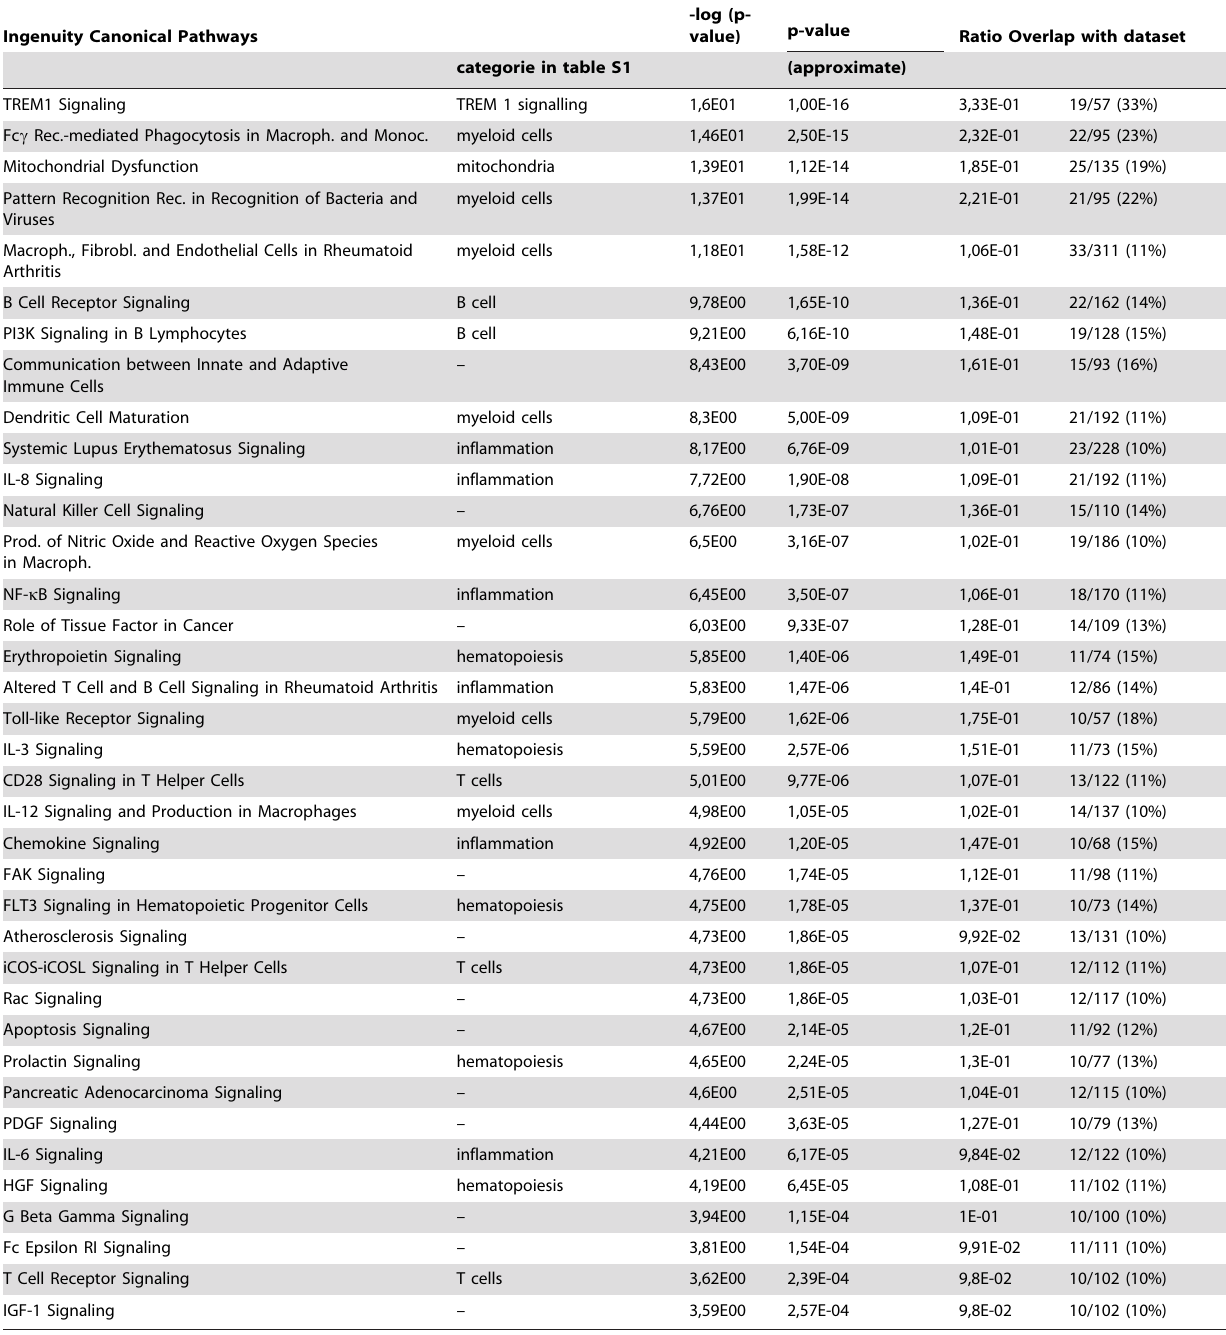
Table 3. Results of Ingenuity pathway